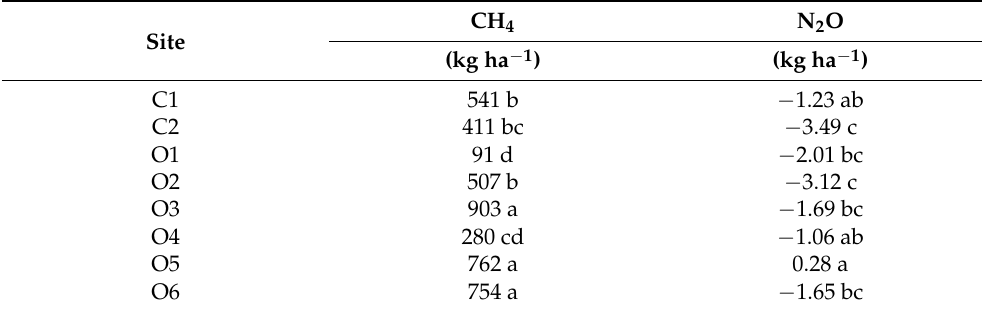
Table 4. Cumulative fluxes of methane (CH 4 ) and nitrous oxide (N 2 O) emitted from paddy soils treated with different fertilization practices during the growing